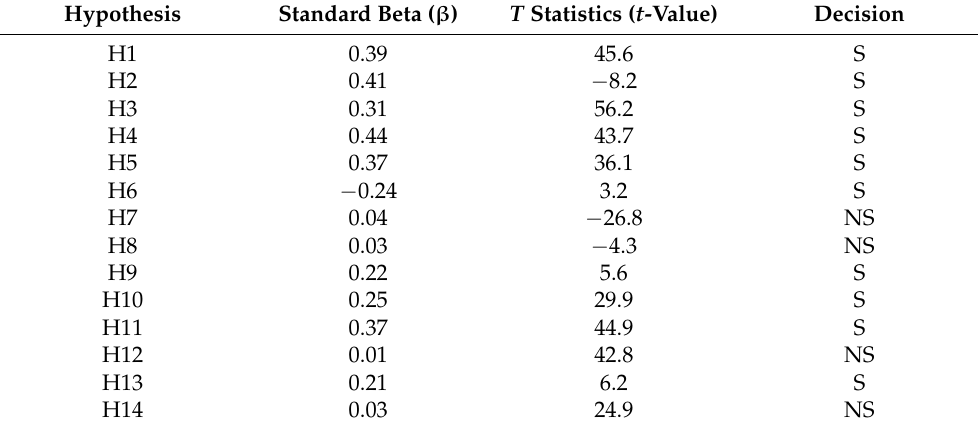
Table 6. Hypothesis testing